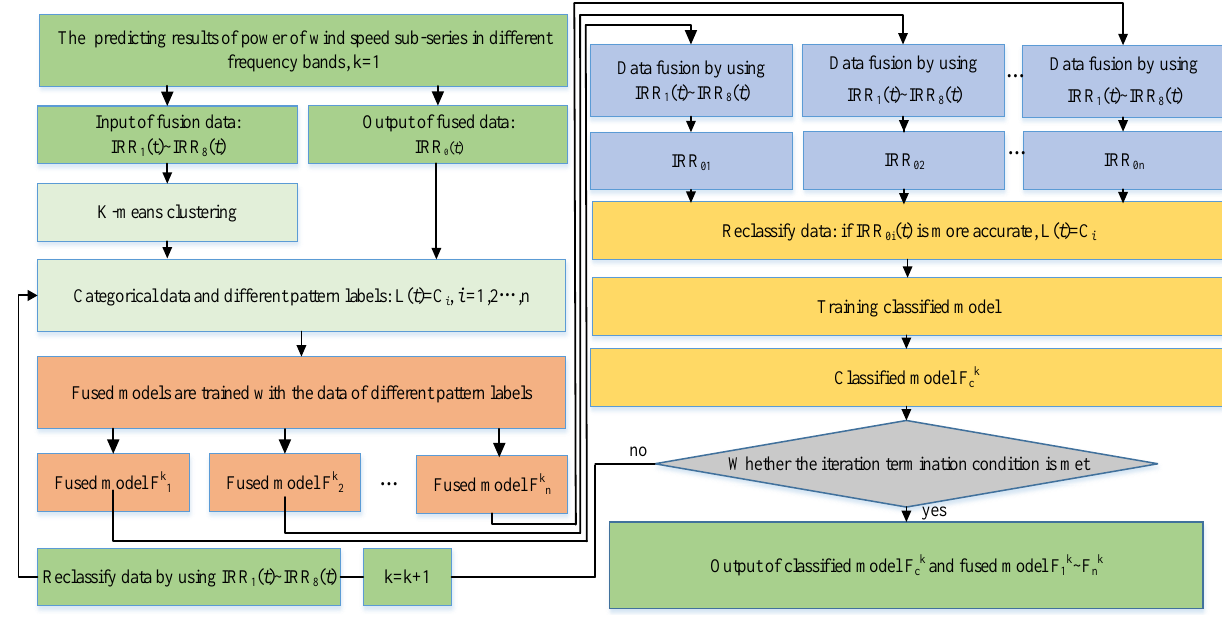
Figure 8. Optimal framework of mutually iteration.